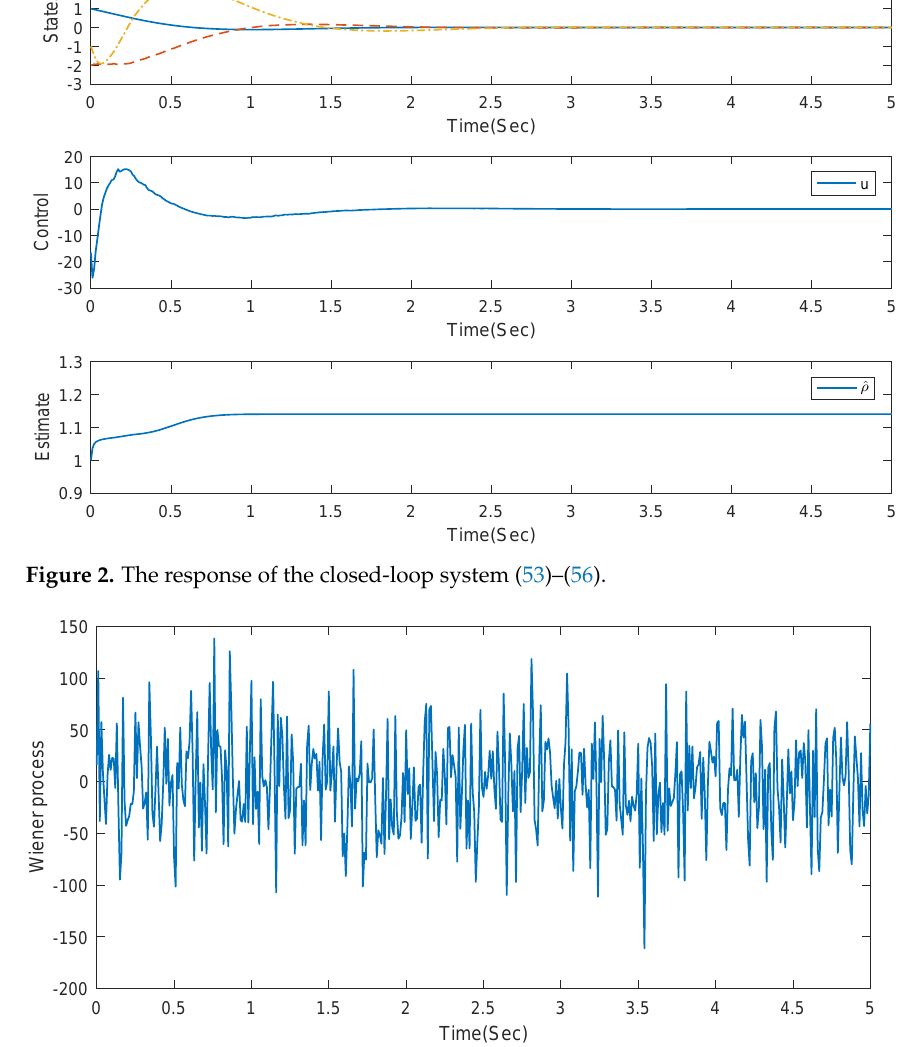
Figure 3. The response of the Wiener